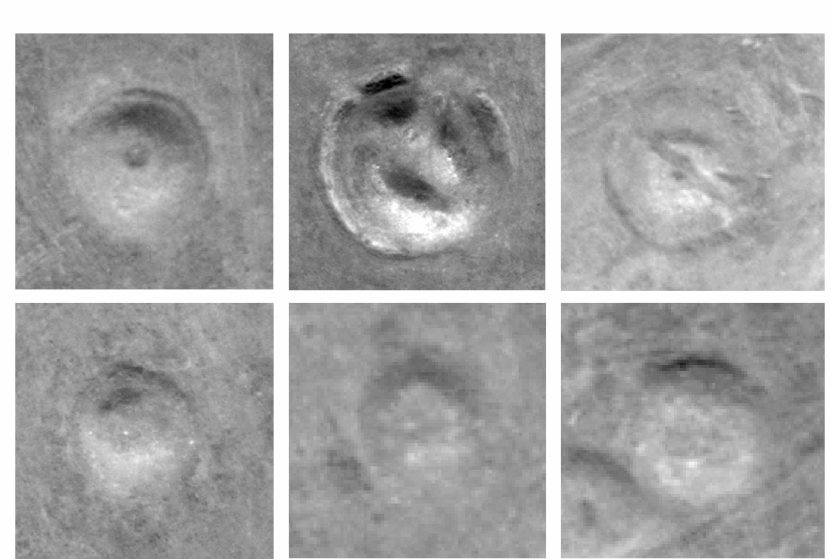
Figure 2. The top row shows “royal” burial mounds which are heavily impacted by looting and thus were attributed to the [impacted] category. The bottom row shows mounds which seem to be well-preserved and are thus attributed to the [well-preserved] category. The bottom right image shows two burial mounds of which only the middle one seems to be well-preserved. All images are scaled to the same size for comparability purposes.